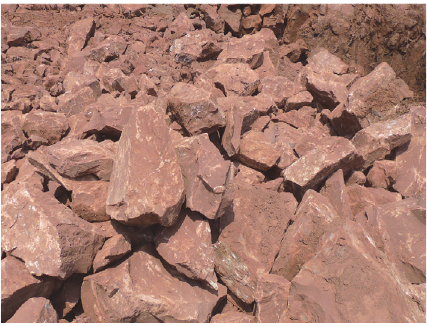
Figure 1: Representative red-bed sandstone